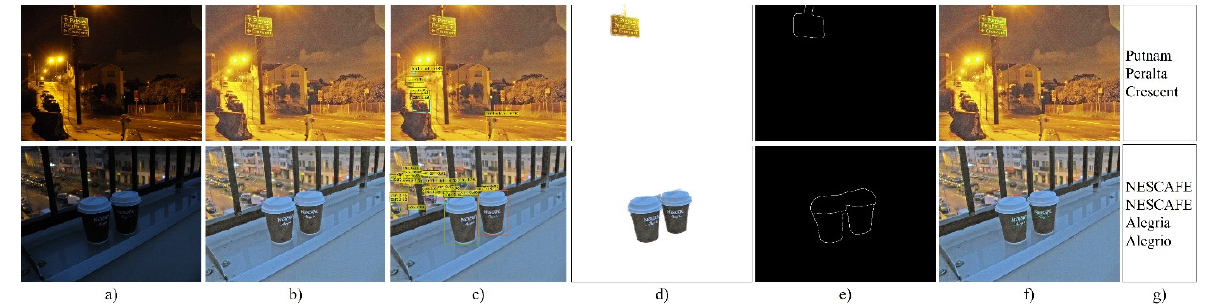
Figure 18. The result of each model of smart glass system. ( a ) Input image; ( b ) low light image enhancement; ( c ) object detection; ( d ) salient object extraction; ( e ) contour detection for tactile graphic; ( f ) text detection; ( g ) recognized text.